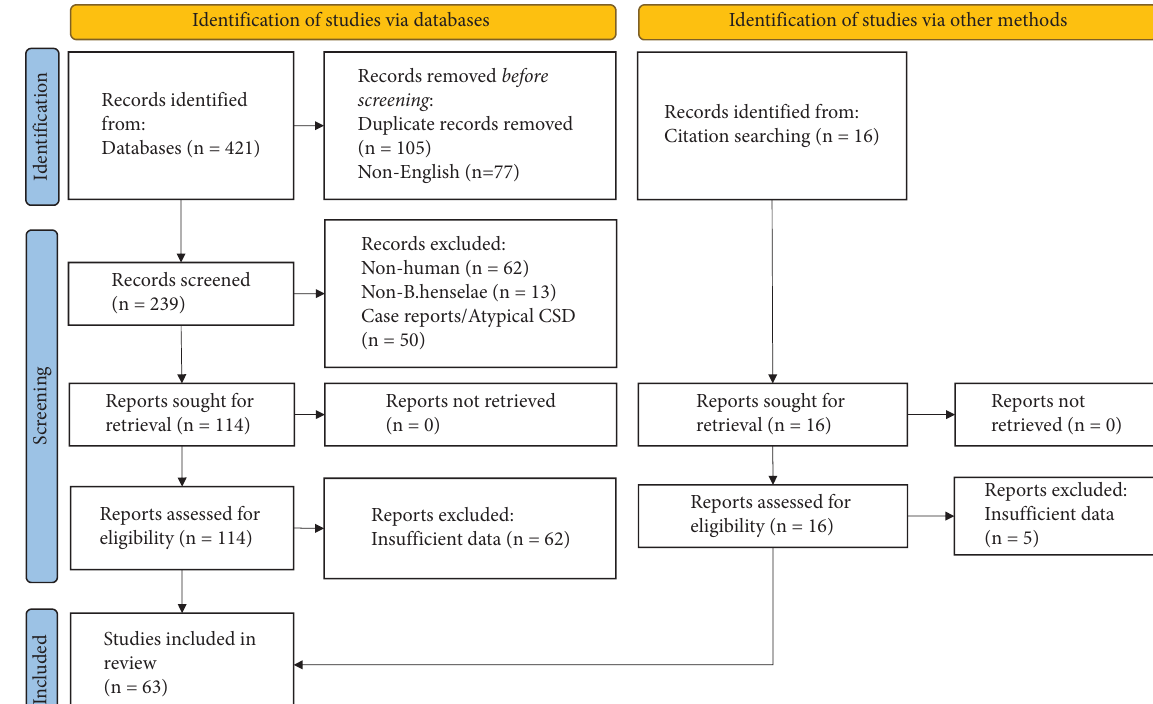
Figure 1: Flow diagram of study selection according to PRISMA